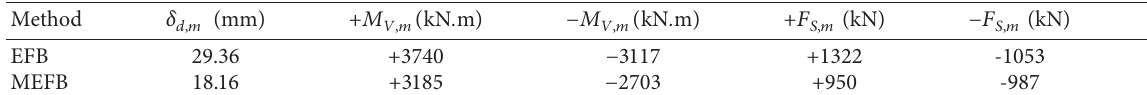
Figure 16: Comparison of the wall deformation using MEFB and EFB methods. Table 6: Calculation results of MEFB method and EFB method.